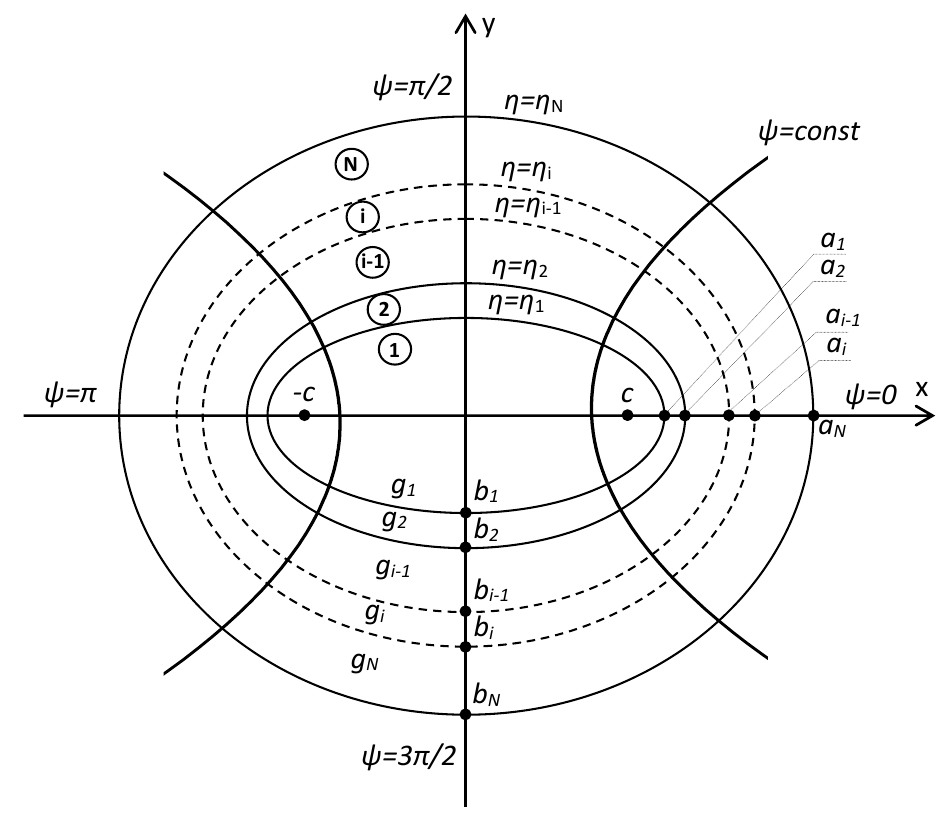
Figure 1. Layered elliptical structure.